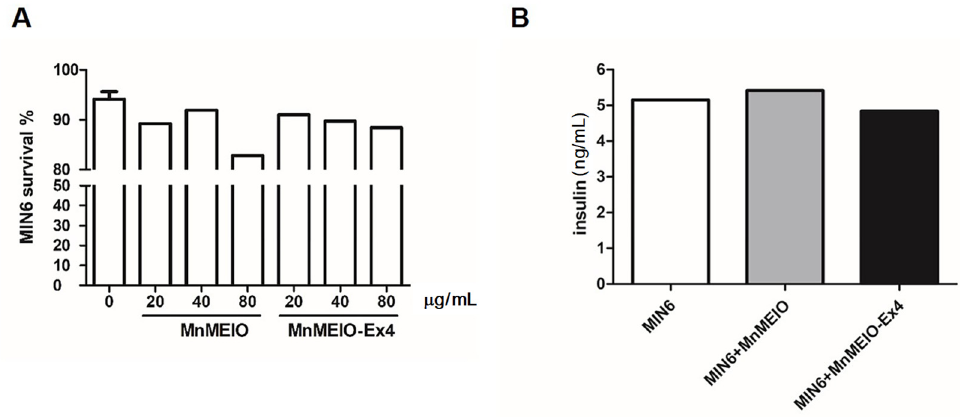
Figure 3. Effects of MnMEIO and MnMEIO-Ex4 NPs on MIN6 cell viability and insulin secretion. ( A ) Dose effects of MnMEIO and MnMEIO-Ex4 NPs on the viability of MIN6 cells. ( B ) Effects of 40 μ g/mL MnMEIO and MnMEIO-Ex4 NPs on insulin secretion of MIN6 cells.